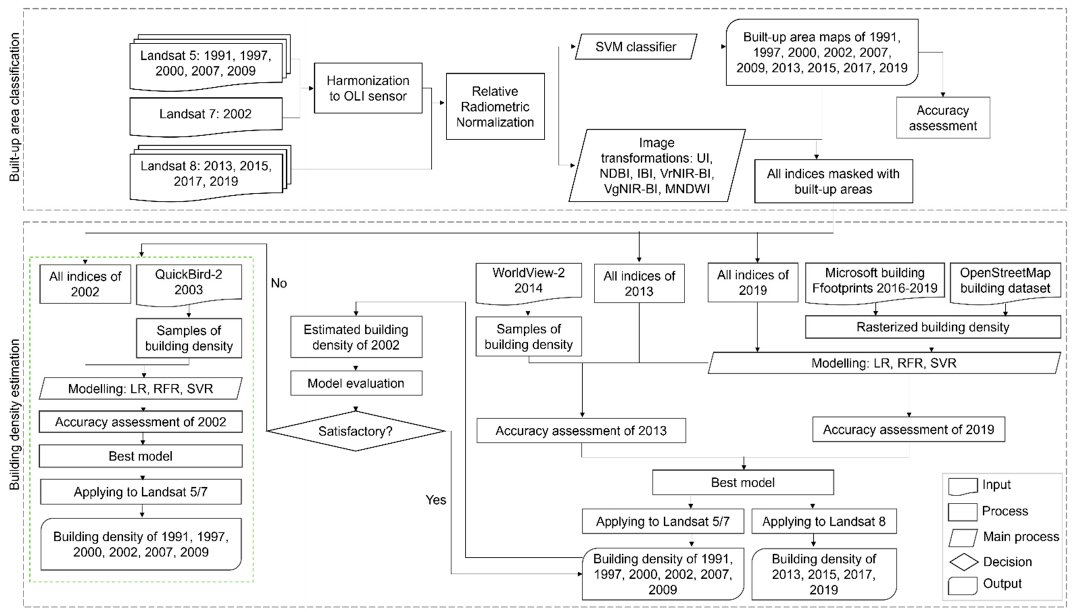
Figure 2. The flowchart of the study generally consists of built-up area classification and building density